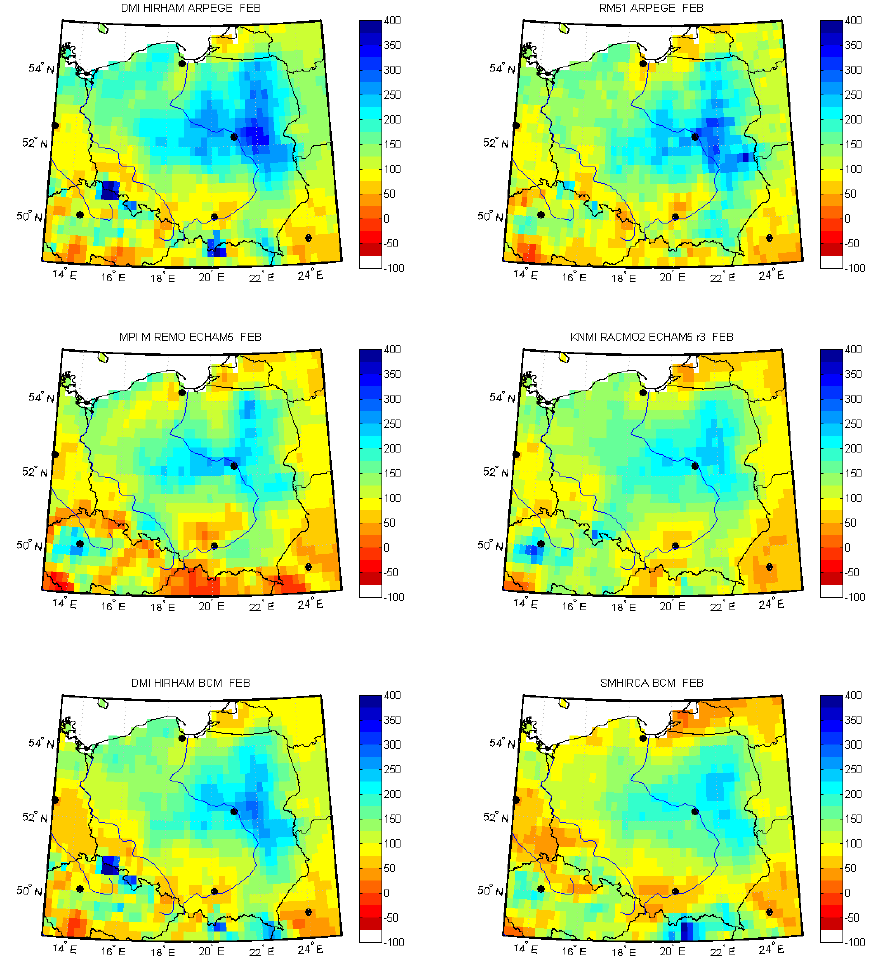
Figure 3. Comparison of spatial patterns of relative differences [%] in the average monthly precipitation in February between uncorrected and bias corrected data for the reference period